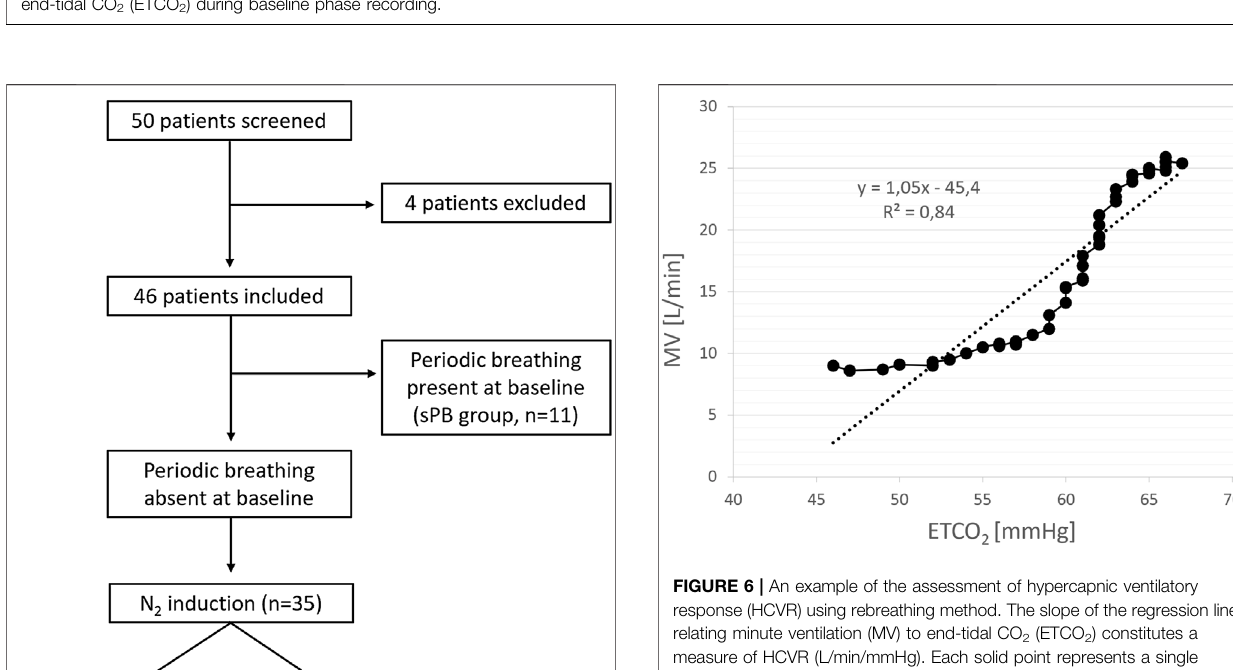
FIGURE 4 | Example of spontaneous periodic breathing (sPB). Continuous recording of oxygen saturation (SpO 2 ), tidal volume (TV), minute ventilation (MV), and end-tidal CO 2 (ETCO 2 ) during baseline phase recording.